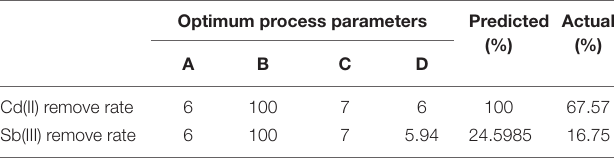
TABLE 3 | Theoretical and actual maximum removal rates of Cd(II) and Sb(III) under optimal conditions.